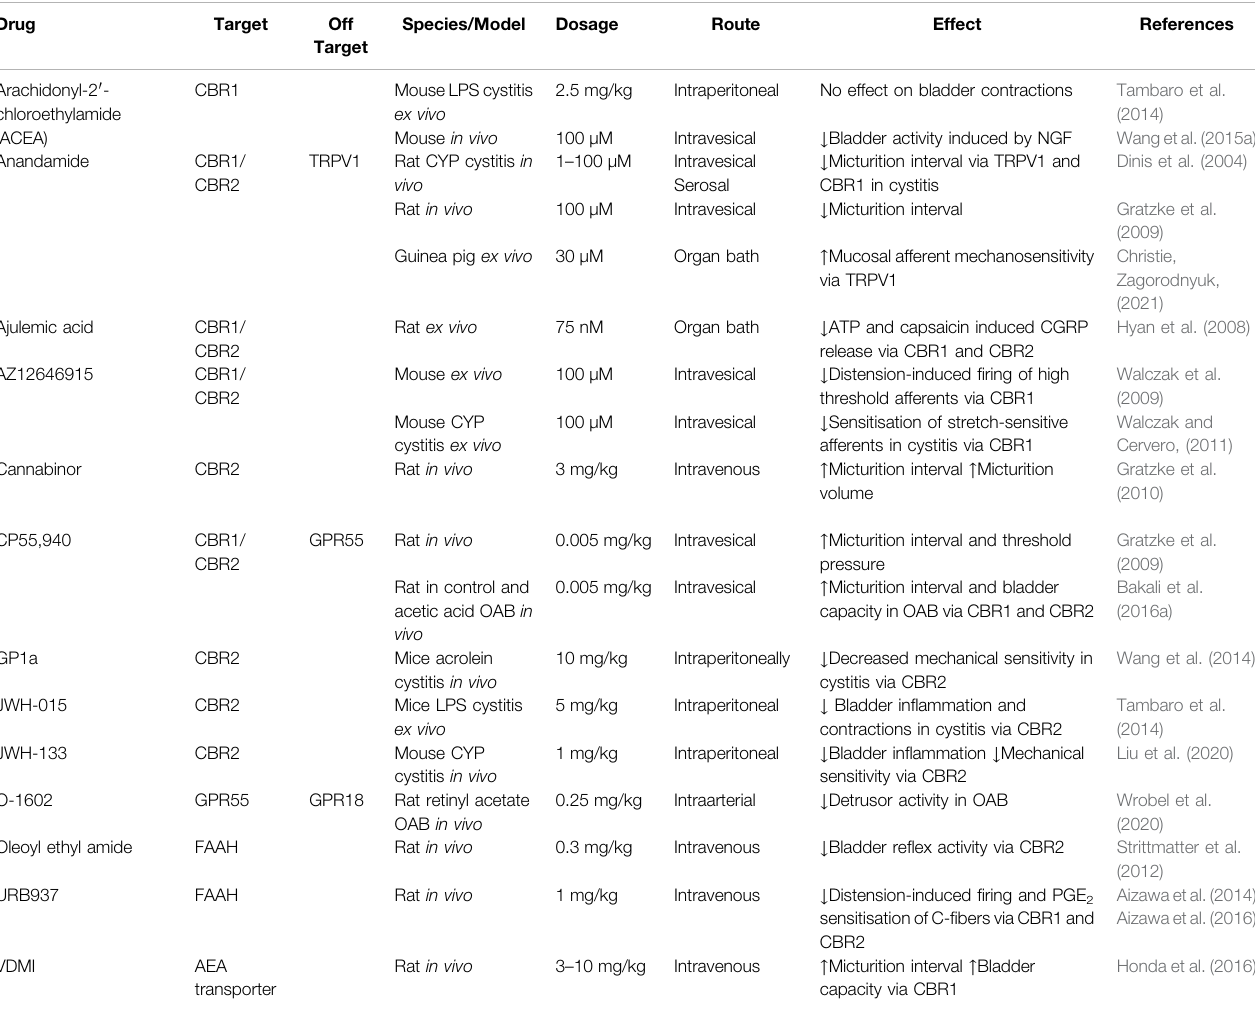
TABLE 1 | Cannabinoid drugs and their effects on sensory neurons and bladder function.